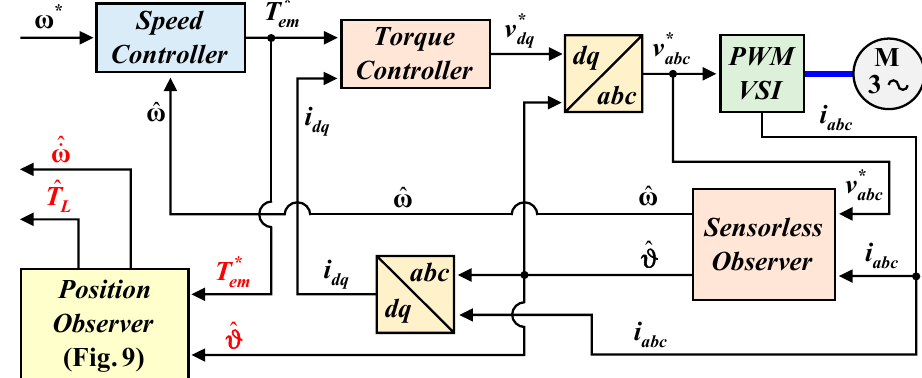
Figure 10. Example of MPTO integration on a sensorless field-oriented control scheme for wash- ers.